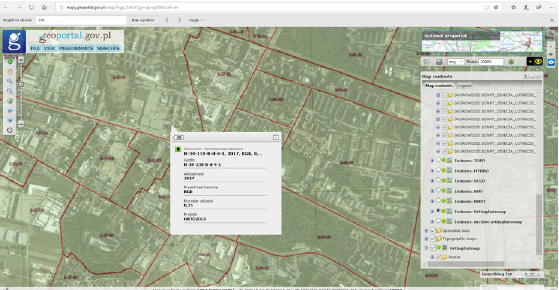
Figure 7. Screenshot of Polish geoportal presenting orthophotomaps.